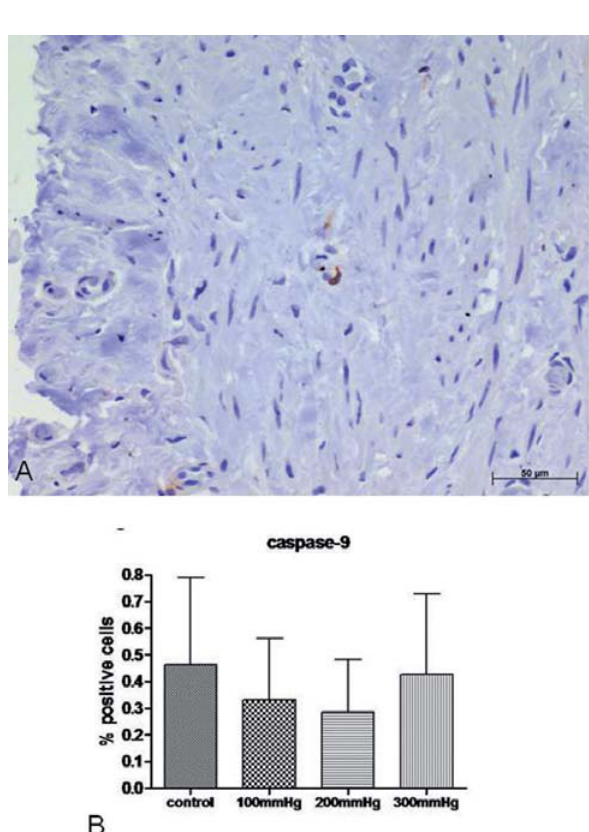
Fig. 3 - Representative photomicrograph of immunohistochemical analysis for expression of caspase 9 in segments of vein submitted for fifteen seconds at 300 mmHg (A): original magnification 400X. (B) The numbers (mean, SD) of the caspase 9 positive cells of approximately 600 cells in control and segments of the vein submitted for fifteen seconds at 100, 200 and 300 mmHg